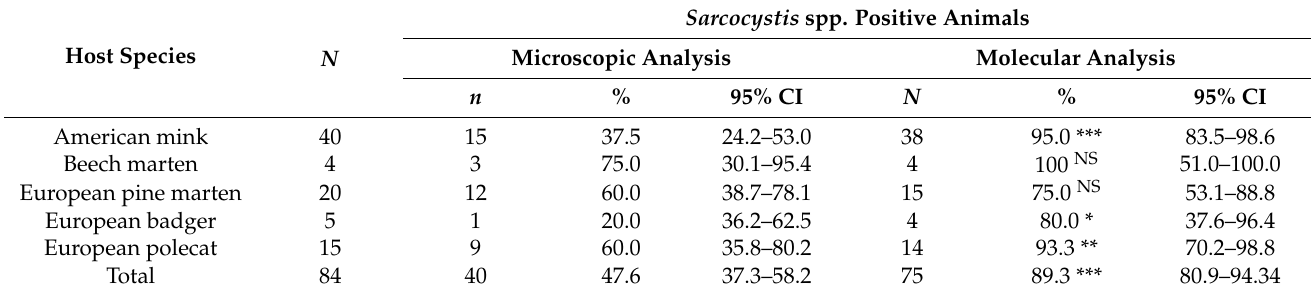
Table 2. Identification of Sarcocystis spp. oocysts/sporocysts in mustelids using microscopic and molecular examination.